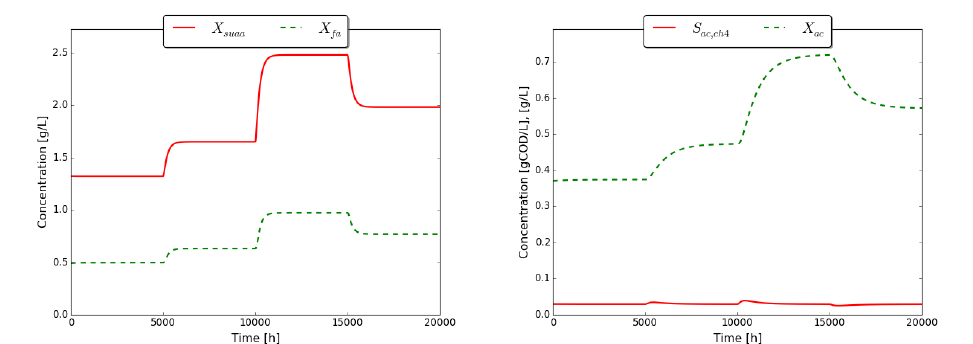
Figure 12. Dynamic behavior of the model solutions with variable X in c from Table